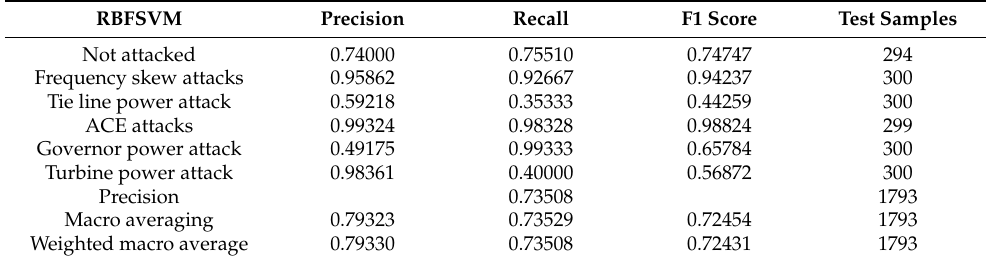
Table A4. The RBFSVM algorithm trained on model indicator data.